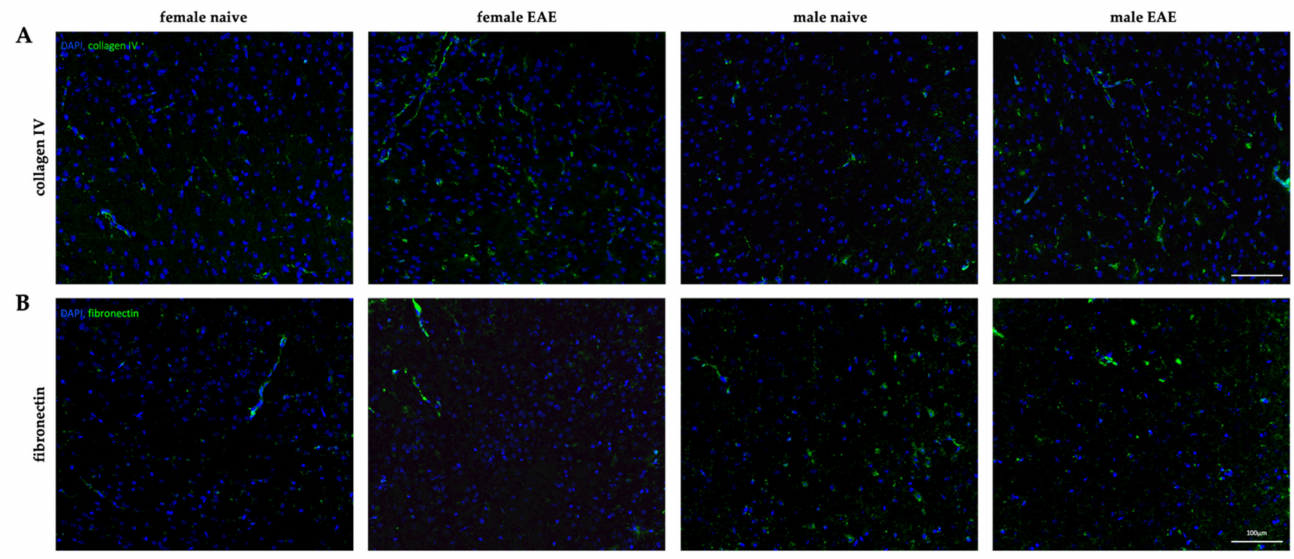
Figure 6. Sexual dimorphism in cortical ECM remodeling in EAE. ( A ) Immunofluorescence of collagen type IV (green) in healthy condition (naive) and at peak EAE for female (left) and male (right) cortices. ( B ) Cortical fibronectin (green) staining of female (left) and male (right) healthy and EAE mice. DAPI (blue). 20 × magnification. Scale: 100 µ